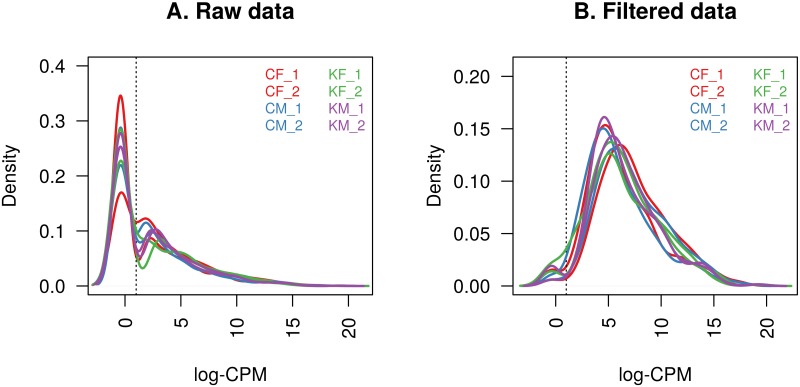
The density of log-CPM values for each sample.A: Raw pre-filtered data B: Post-filtered data The dotted vertical lines mark the log-CPM of one threshold (equivalent to a CPM value of 10) used in the filtering step.